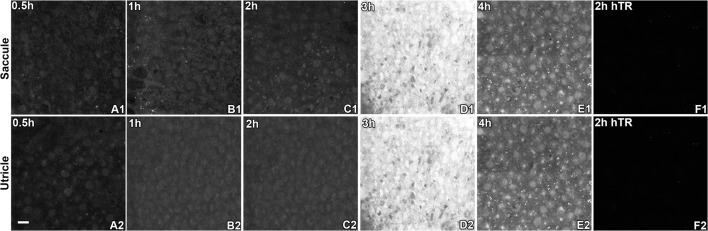
GTTR fluorescence in macular sensory epithelia peaked 3 hours after injection.Diffuse, cytoplasmic GTTR fluorescence was detected in saccular (A1-A5) and utricular (B1-B5) hair cells at 0.5 hours and increased over time to peak at 3 hours after systemic injection of GTTR. At 4 hours, diffuse cytoplasmic fluorescence was visibly attenuated. Note that fluorescent puncta were generally located within the diffuse cytoplasmic fluorescence of supporting cells; the diffuse fluorescence in supporting cells was generally less intense compared to hair cells in either macula (e.g., E1 and E2). Mice injected with hydrolyzed Texas Red for 2 hours had negligible fluorescence in either macular epithelium (F1-F2). Scale bar in A2 = 20 μm.